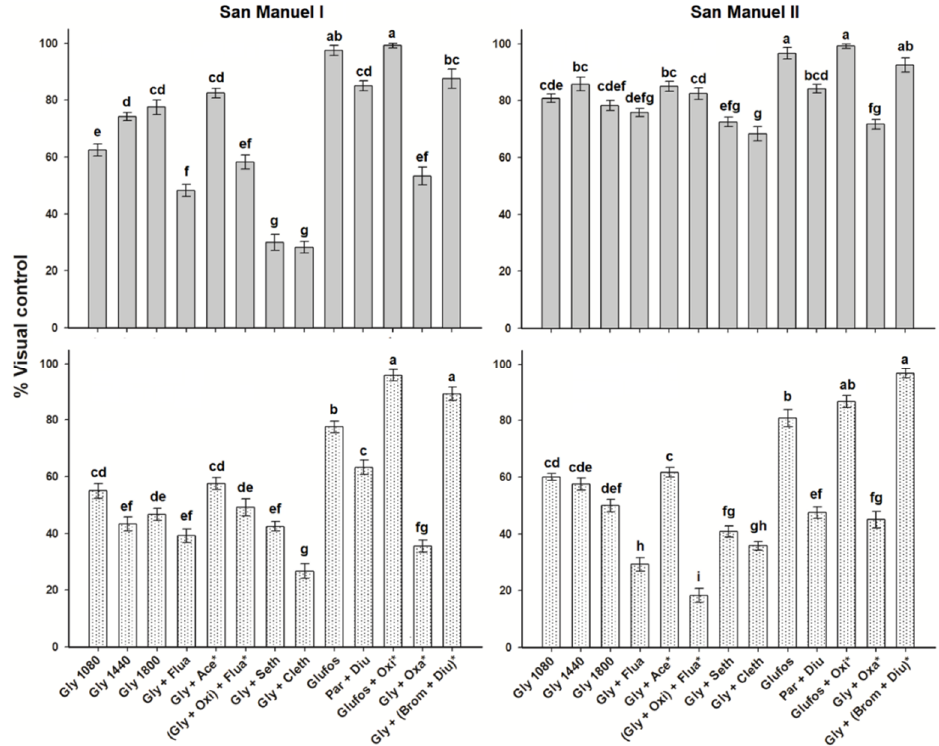
Figure 1. Control of Bidens pilosa in two Persian lime groves of the “San Manuel” Farm, Puebla, Mexico, at 30 (gray bars) and 75 (dotted bars) d after treatment. Same letter within a subfigure showed no di ff erences between treatments by the Tukey test ( P > 0.05). Vertical bars ± standard error from combined data of field trials carried out in 2014 and 2015 ( n = 6).